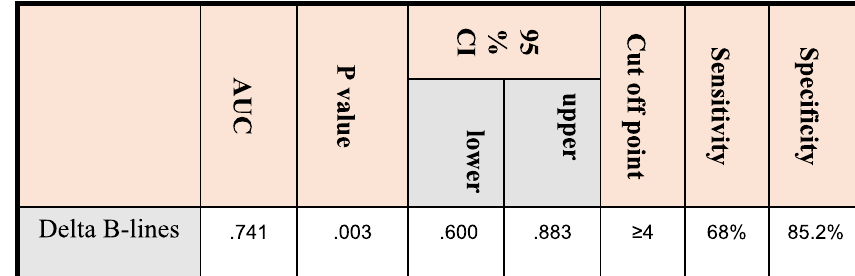
Table 4 Logistic regression analysis for the most important predictor factors of weaning‑induced pulmonary edema